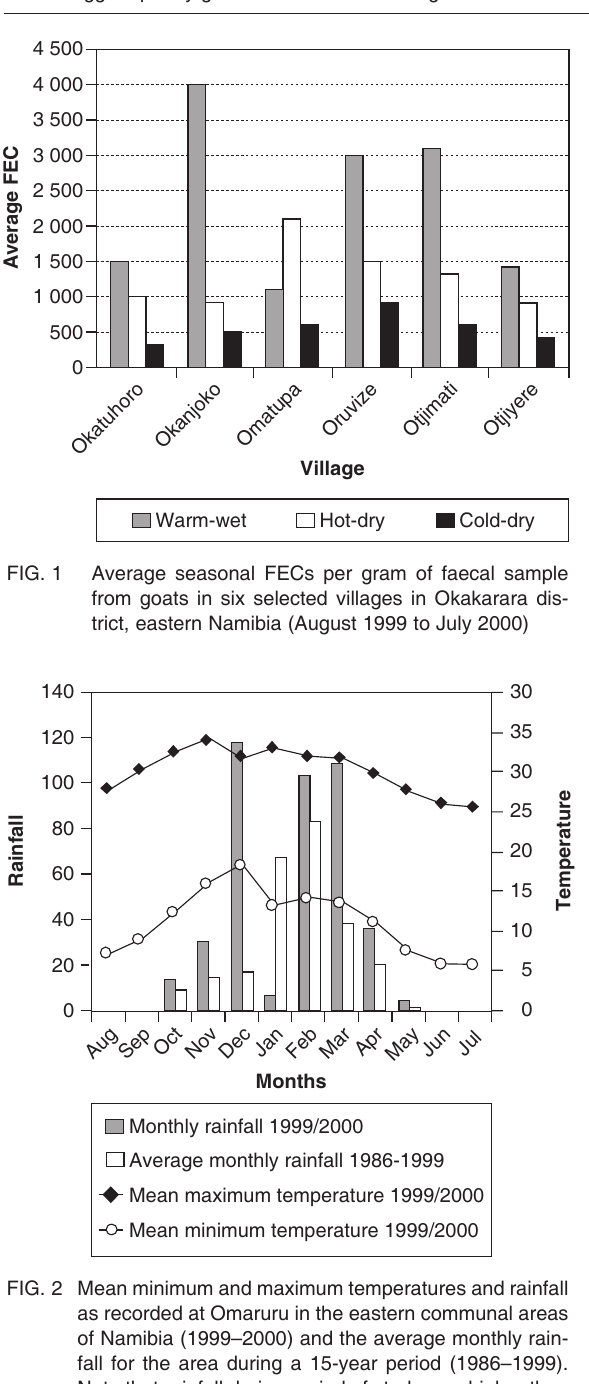
Faecal egg output by gastrointestinal worms in goats in eastern Namibia